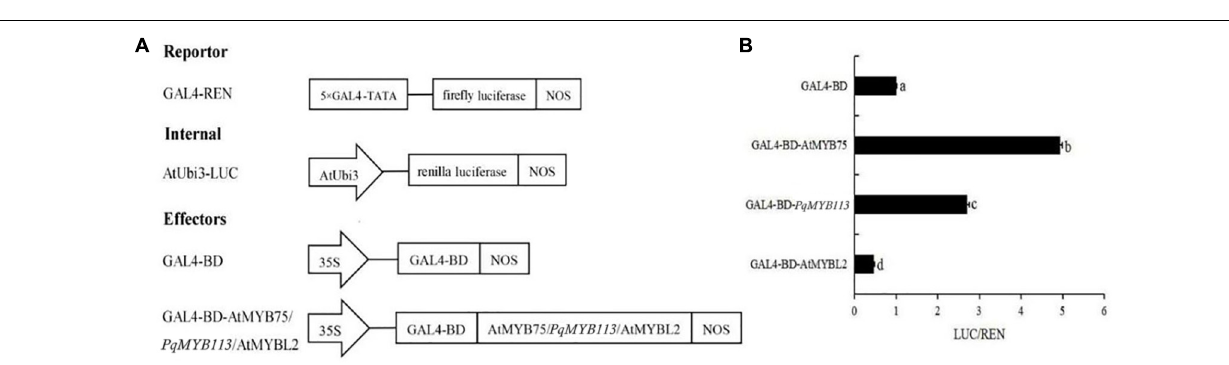
FIGURE 5 | The Dual Luciferase Transient Transfection Assay of PqMYB113 . (A) The schematic depiction of the constructs used in the Arabidopsis protoplast co-transfection assay. (B) The relative luciferase activity (LUC/REN). a, b, c, and d indicate significant differences at the p ≤ 0.05 level by Duncan’s